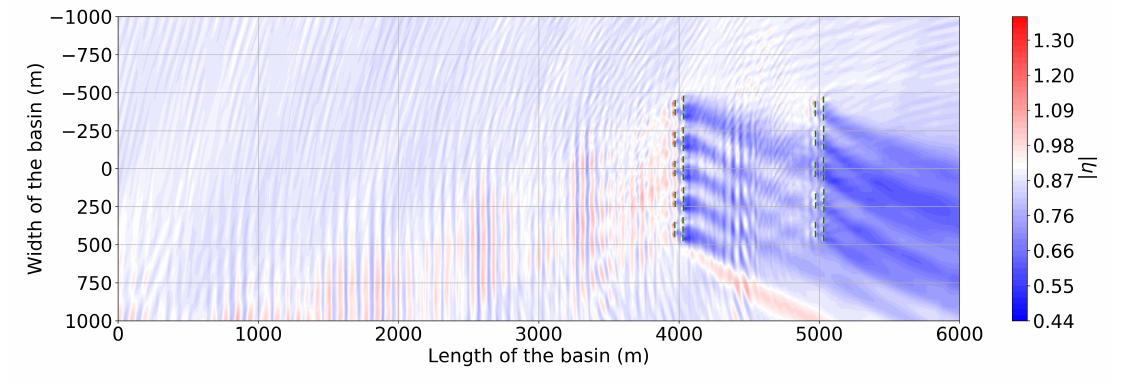
Figure 17. Coupled total | η | for the mean autumn wave H m 0 = 1.80 m, T p = 10.54 s, and β = − 22 ◦ for a 50 WEC 10-Array